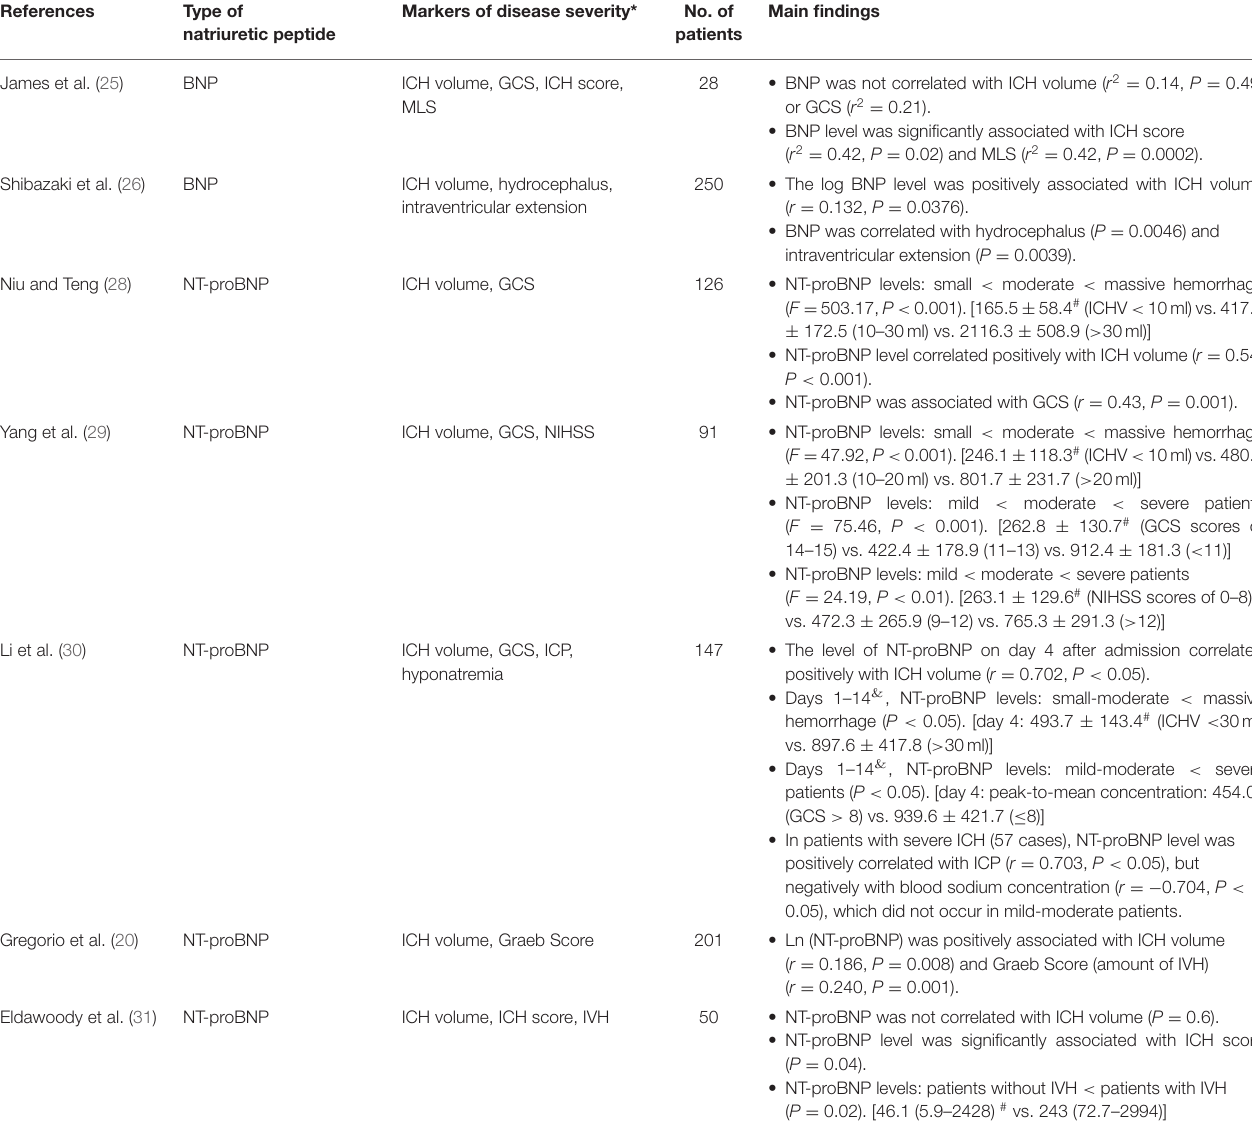
TABLE 3 | The correlation between BNP/NT-proBNP levels and severity of